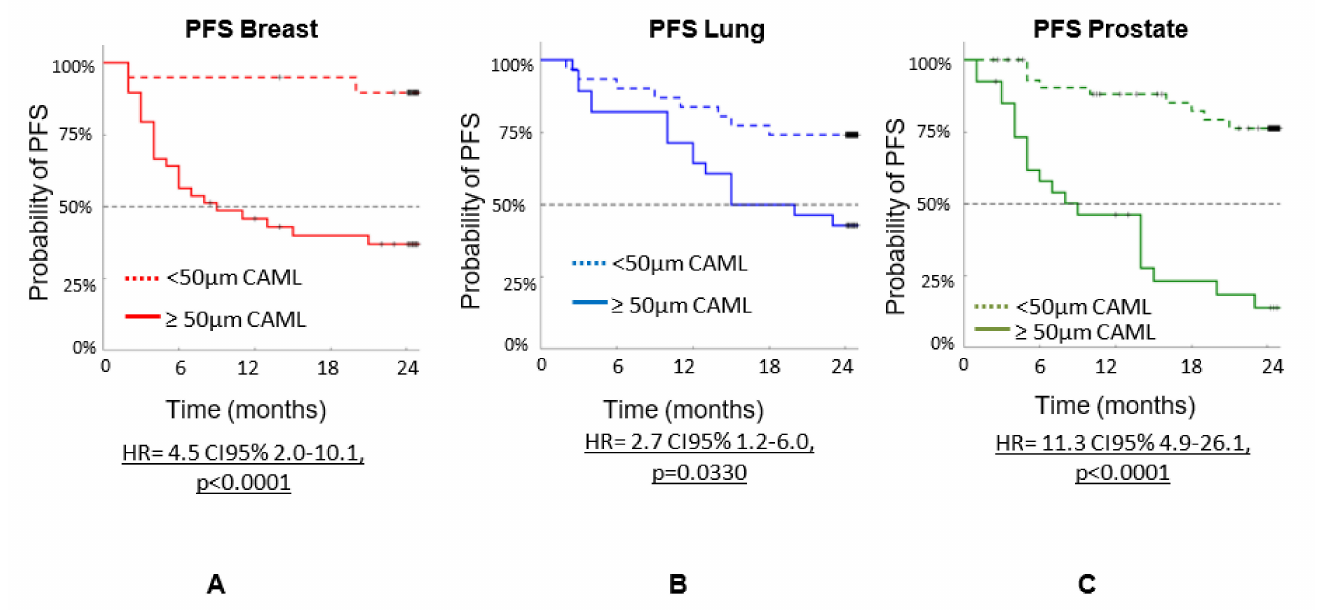
Figure 3. n = PFS of 192 patients with three types of cancers (breast, prostate, and lung). PFS is based on CAML size determined during a 24-month follow-up. ( A ) is PFS for breast cancer patients. ( B ) is PFS for lung cancer patients and ( C ) is PFS for prostate cancer patients. The data shows that patients with CAMLs ≥ 50 µ m all has shorter PFS than patients with CAML < 50 µ m independent of type of